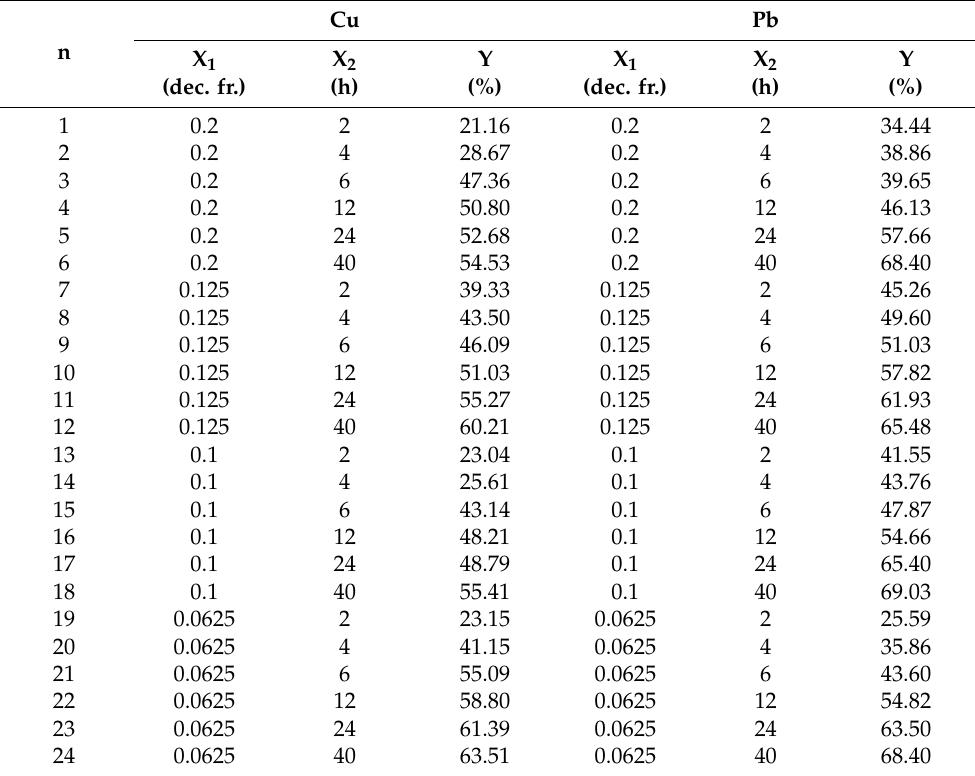
Table 2. Experimental data obtained during soil washing experiments using a 5% chitosan solution and used in the elaboration of the mathematical